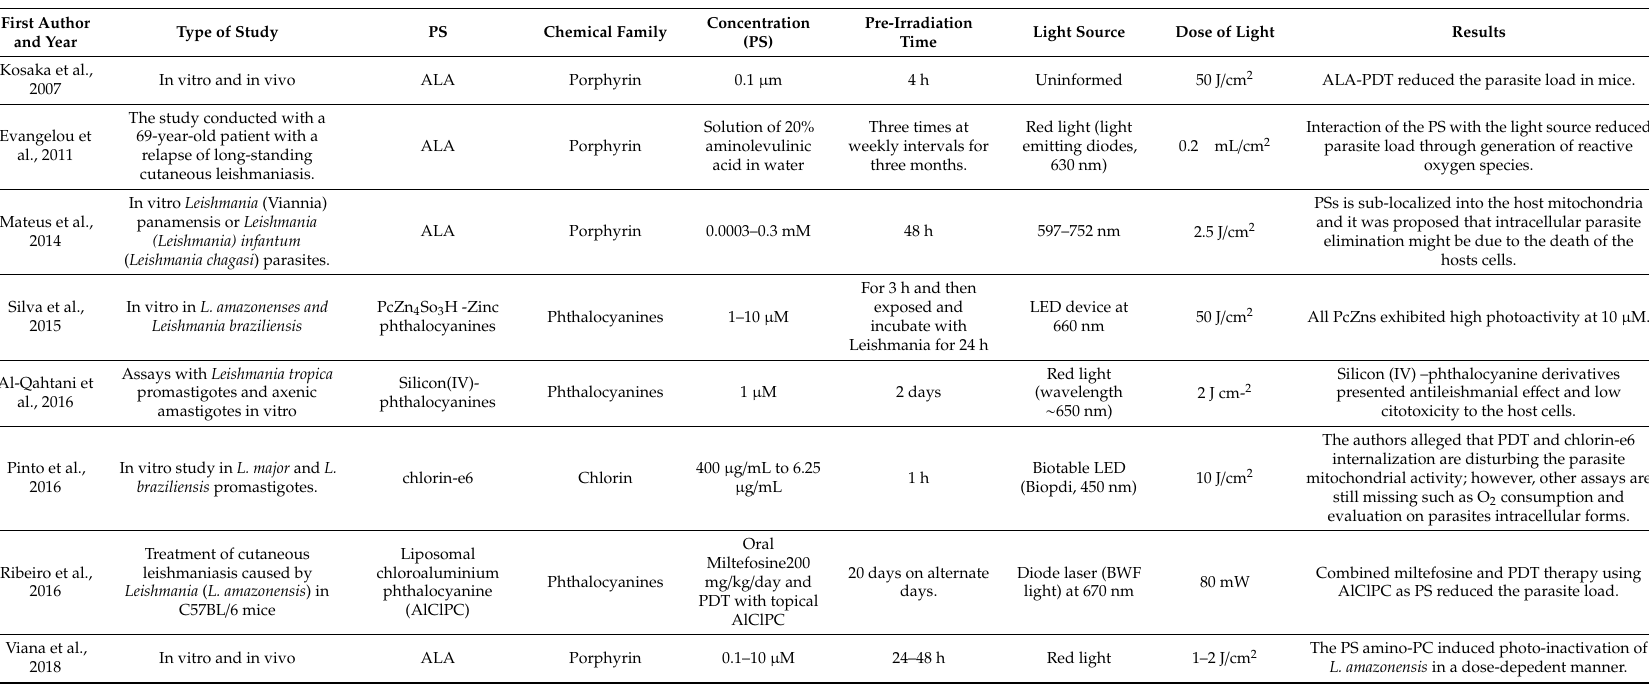
Table 5. Description of studies using porphyrins, phthalocyanines, and chlorins in the treatment of cutaneous